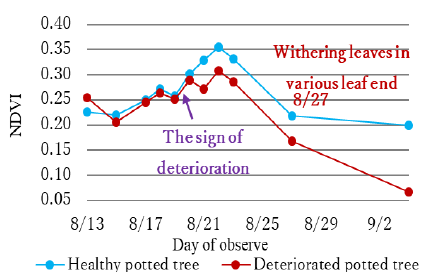
Figure 15. Changes in NDVI in healthy and degraded trees